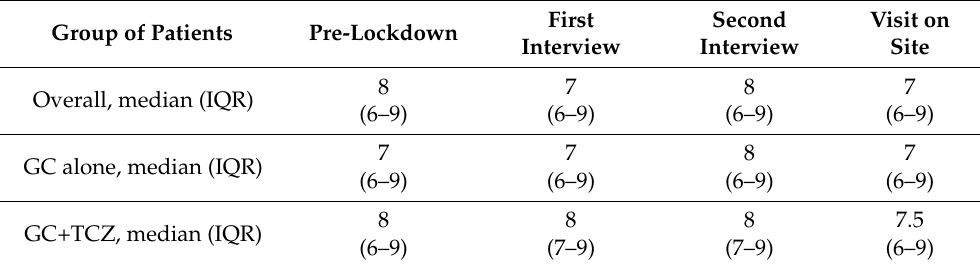
Table 3. Medication Adherence Rating Scale (MARS) assessed during the